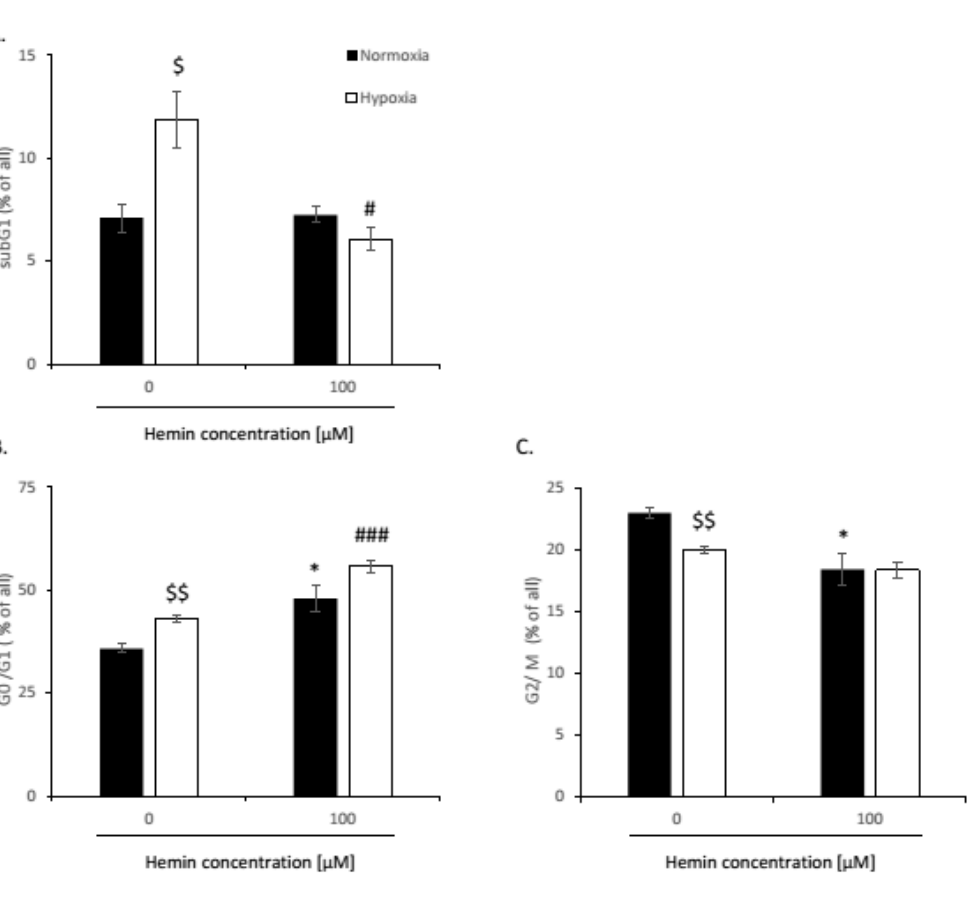
Figure A12. High hemin concentration correlates with an escape from senescence of hypoxic SW480 cells: cell number and activity of SA- β -Gal. Cells were cultured in parallel in normoxia or hypoxia. Cells were exposed to 100 µM hemin. Control cells were subjected to IRINO and NaOH in the corresponding dose. ( A ) Evaluation of cell number. Cell number was counted using Bürker’s chamber. ( B ) Activity of SA- β -Gal enzyme in IRINO-treated cells subjected to hemin under normoxic or hypoxic conditions. Detection of the enzyme was performed on cytospined cells. ( C ) Quantification of SA- β -Gal positive cells after treatment with hemin. Representative photos were acquired using light microscopy. Original magnification 200 x, scale bar 50 µ M; Each bar represents mean ± SEM, n ≥ 3; * p < 0.05—vs. control normoxia; ## p < 0.01—vs. control hypoxia; $$$ p < 0.001—normoxia vs. hypoxia.